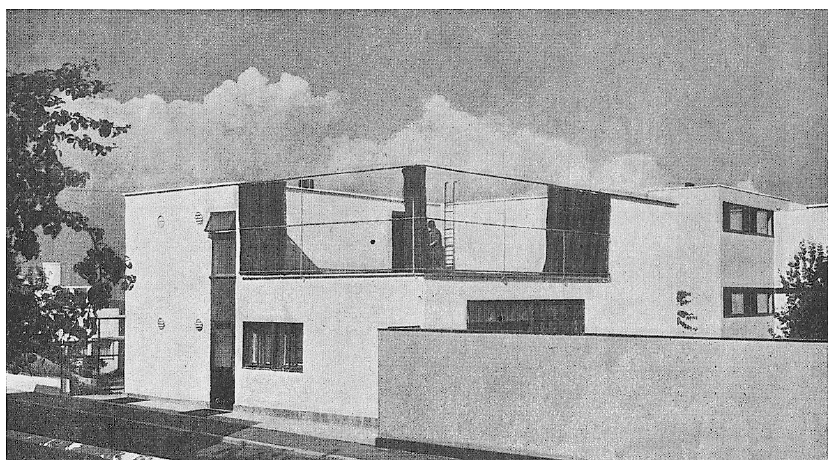
Figure 12. Walter Gropius: House number 16 at the Stuttgart Werkbund exhibition Am Weißenhof, 1926–1927. Photo from (Gropius 1927a, p. 61).